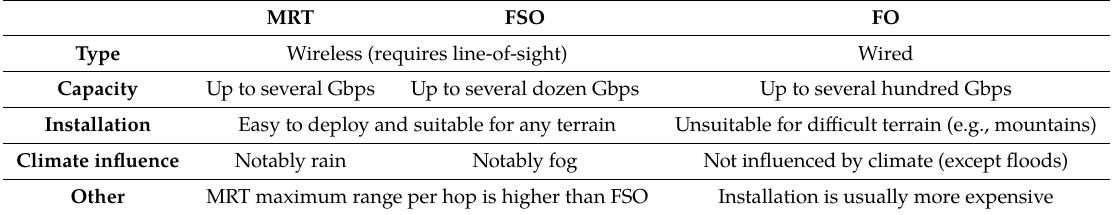
Table 1. Comparison of typical fronthaul communication